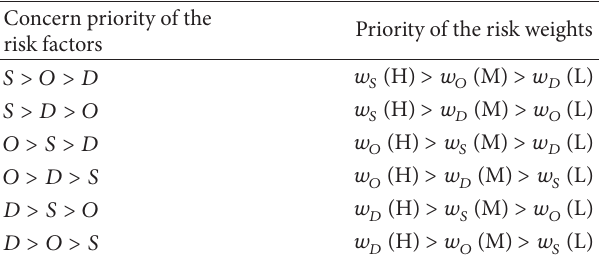
Table 2: Priority of the risk weights with respect to concern priority of the risk